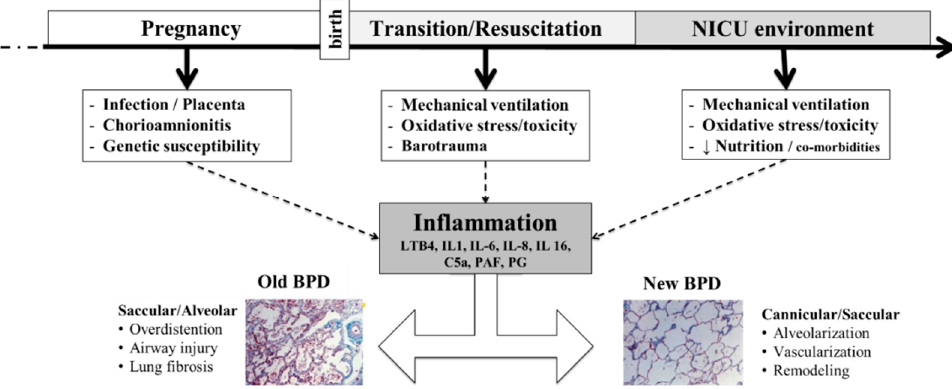
Figure 3. The three phases of lung inflammation contributing to bronchopulmonary dysplasia in preterm infants.